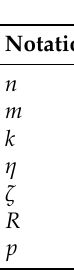
Table 2. Simulation